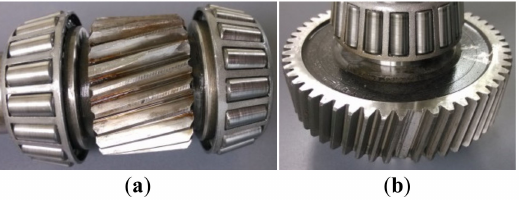
Figure 12. ( a ) Pinion-tooth partial fracture fault and ( b ) gear-tooth fracture fault.